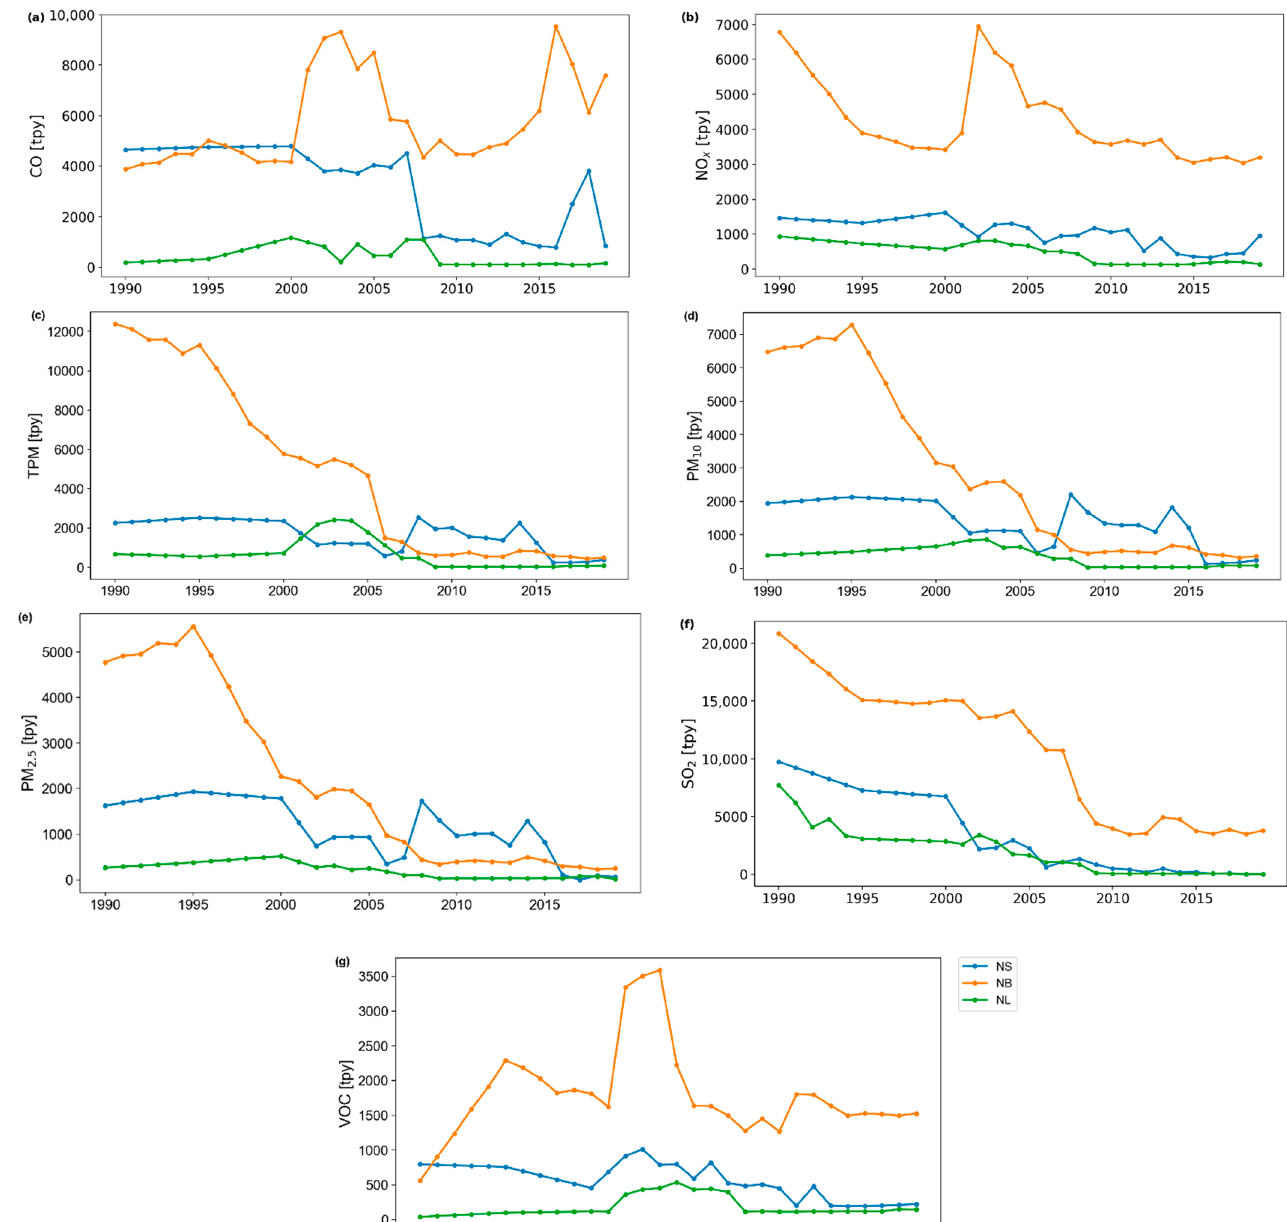
Figure 2. Air emissions registered in the APEI for Nova Scotia, New Brunswick and New- foundland, and Labrador for pollutants ( a ) CO, ( b ) NO x , ( c ) TPM, ( d ) PM10, ( e ) PM2.5, ( f ) SO 2 , and ( g )